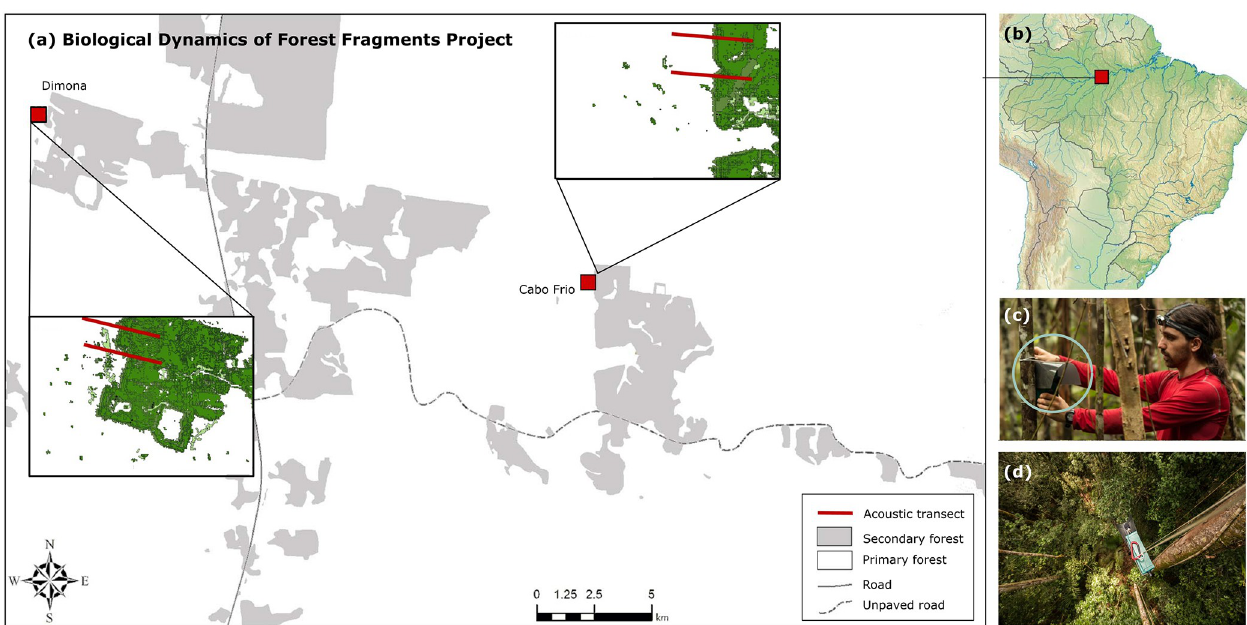
Fig 1. Location of the primary-secondary forest transects at the Biological Dynamics of Forest Fragments Project, Central Amazon, Brazil. (a) Transect location within the BDFFP is presented in the inserts, where primary forest is denoted in white and secondary forest is presented in green. (b) Location of the BDFFP in Brazil. Photographs show the plastic dividers used to ensure acoustic recordings from the understory (c) and canopy samples (d) were independent.